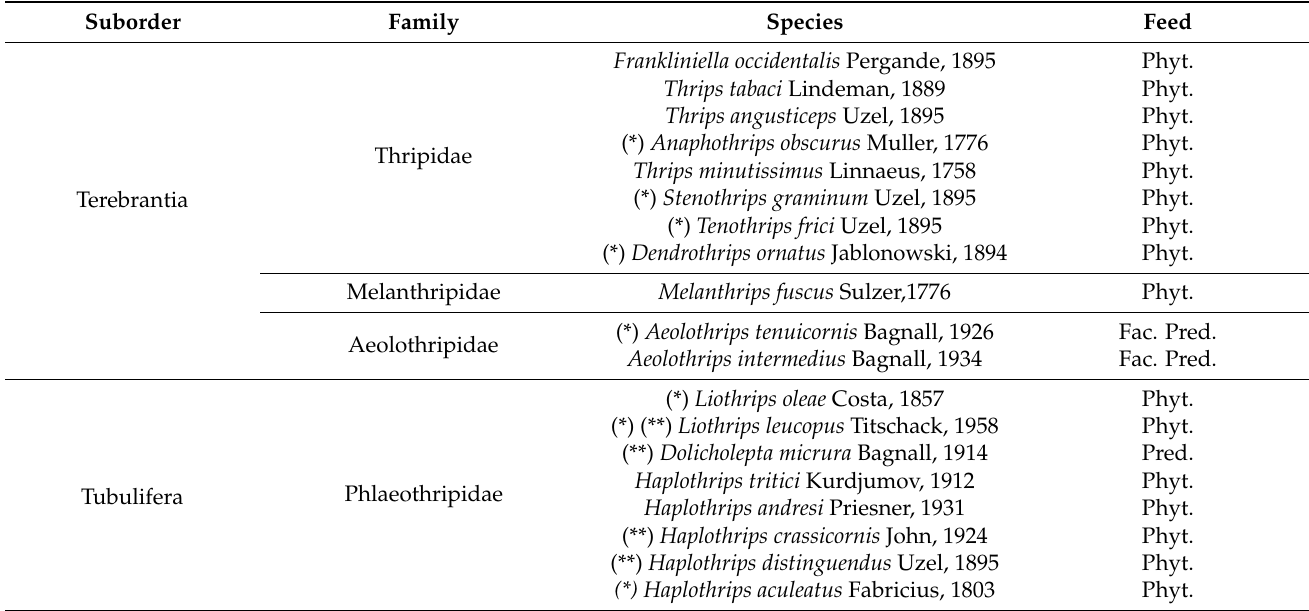
Table 1. The different species of thrips recorded on olive trees in the province of Batna (2019–2021).